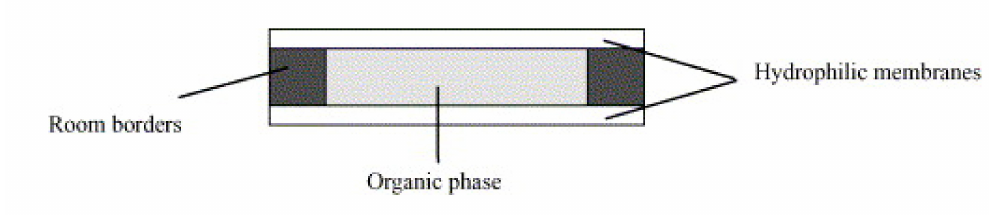
Figure 8. Schematic representation of the stagnant sandwich liquid membranes (SSwLM)